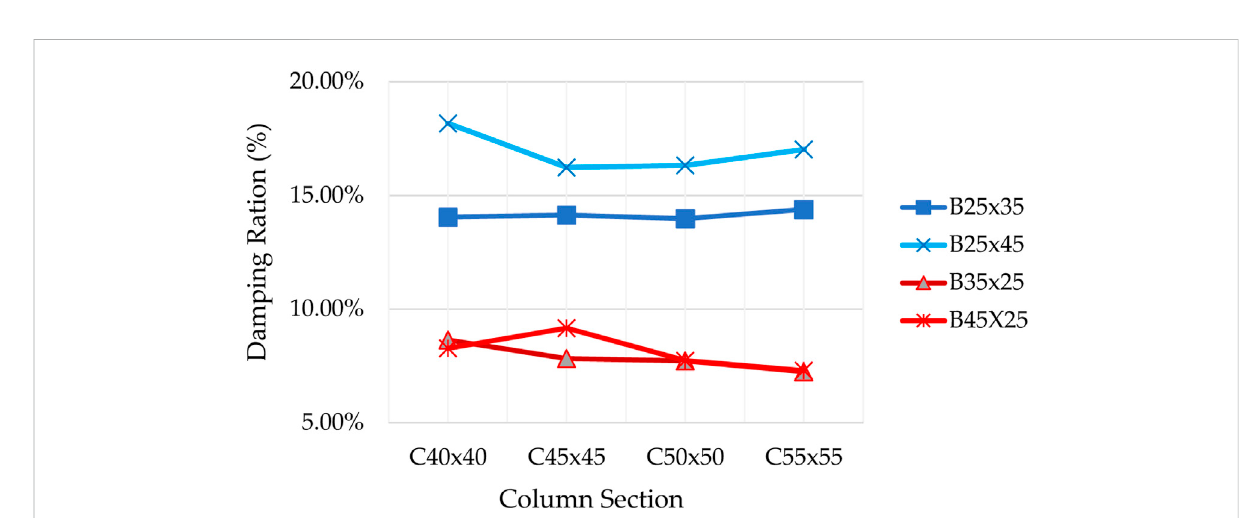
FIGURE 9 Effective period results.